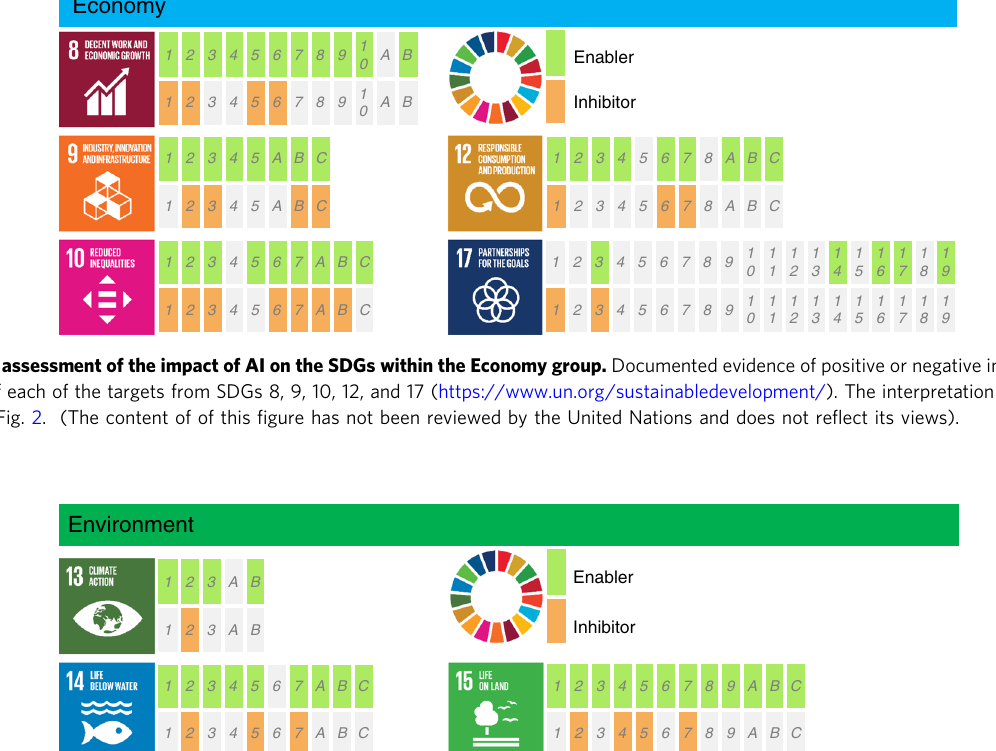
Fig. 4 Detailed assessment of the impact of AI on the SDGs within the Environment group. Documented evidence of positive or negative impact of AI on the achievement of each of the targets from SDGs 13, 14, and 15 (https://www.un.org/sustainabledevelopment/). The interpretation of the blocks and colors is as in Fig. 2. (The content of of this fi gure has not been reviewed by the United Nations and does not re fl ect its